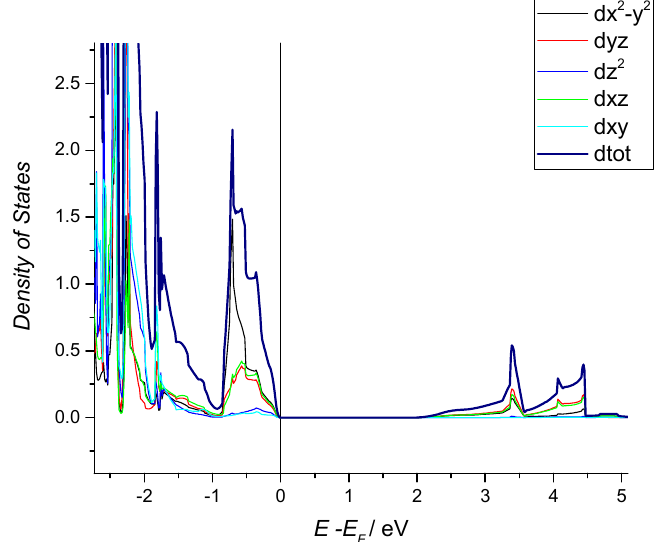
Figure 10. Split density of states (DOSs) of Cu 2 O obtained with VASP and HSE06 method. All the energies are reported to the Fermi level one.